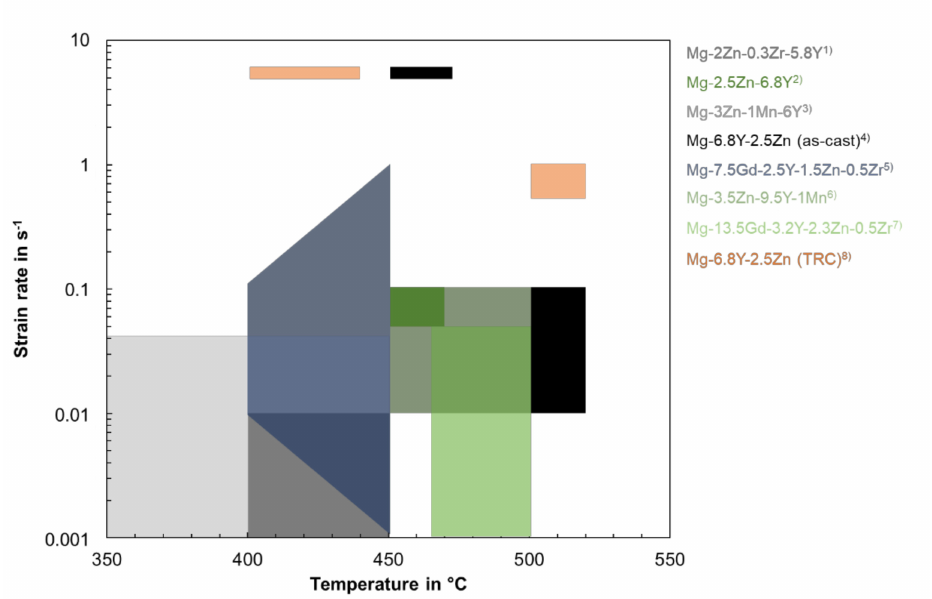
Figure 14. Process windows for several LPSO containing magnesium alloys based on processing maps: (1) [27] (2) [40] (3) [41] (4) [1] (5) [42] (6) [8] (7) [9] (8)